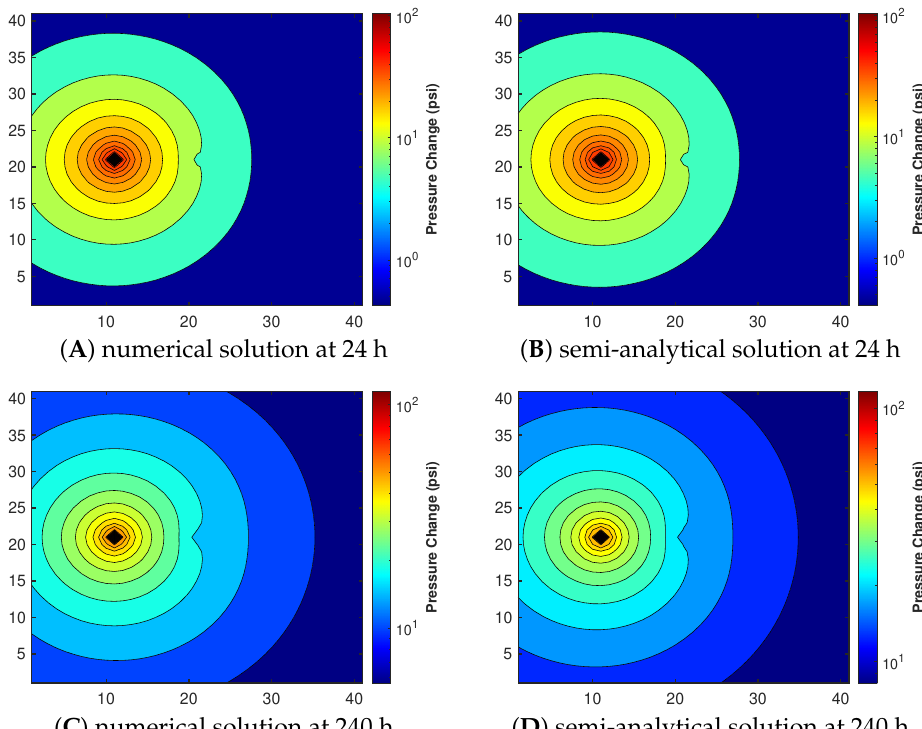
Figure 7. Comparison of the pressure distribution maps obtained by the semi-analytical and numeri- cal methods in the lower layer after 24 h ( A , B ) and 240 h ( C , D